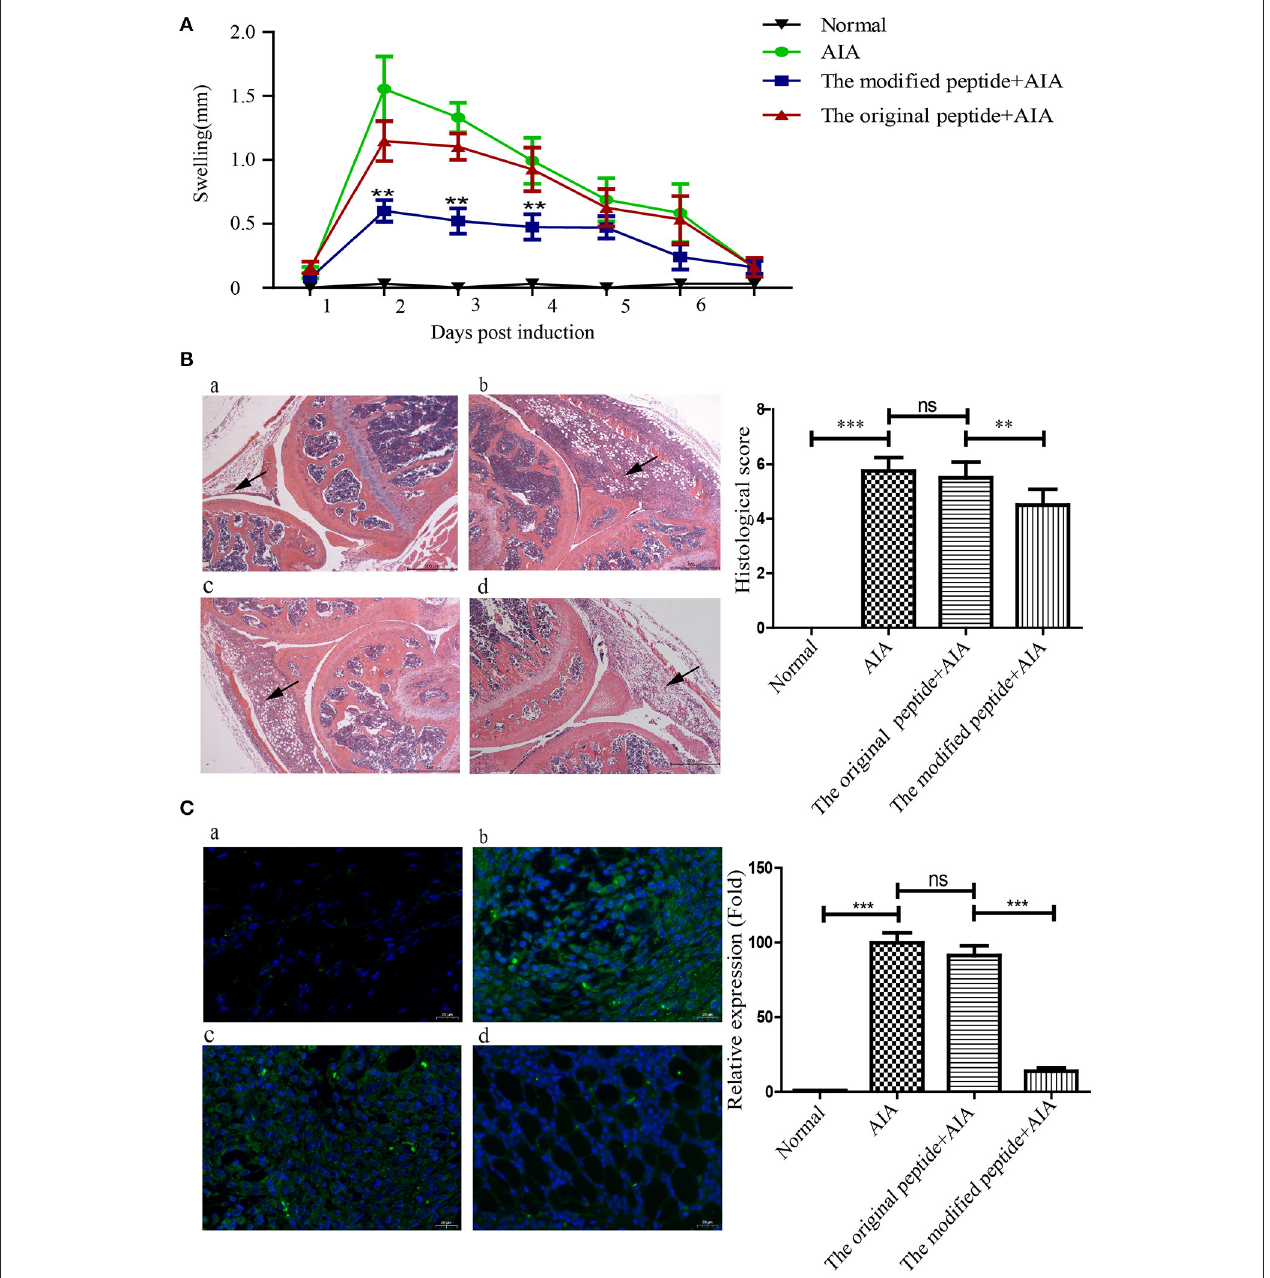
FIGURE 5 | Modified peptide reduced joint inflammation and membrane attack complex (MAC) deposition in mice with antigen-induced arthritis (AIA). The right knee joint of each mouse was intraarticularly injected with 10 µ l PBS as a control, while the left knee joint was injected with either 10 µ l PBS only (normal group), 25 µ g mBSA in 10 µ l PBS (AIA-only group), 40 µ g original peptide with 25 µ g mBSA in 10 µ l PBS (original peptide + AIA group), or 40 µ g modified peptide with 25 µ g mBSA in 10 µ l PBS (modified peptide + AIA group). (A) Swelling of the left knee joint relative to the right knee joint was measured daily. Data are presented as mean ± SD. n = 6, ** p < 0.01. (B) Representative histologic sections of murine knee joints stained with hematoxylin and eosin. a: normal group, b: AIA-only group, c: original peptide + AIA group, d: modified peptide + AIA group. n = 6. Magnification × 10. Arrowheads indicate the swollen synovial tissue. (C) Comparisons of C9 deposition in the knee joint sections among the four groups based on immunofluorescence assays. a: normal group, b: AIA-only group, c: original peptide + AIA group, d: modified peptide + AIA group. n = 6 *** p < 0.001, ns, not significant ( p > 0.05). peptide + AIA mice, but it was significantly weaker in the infiltration compared to the AIA-only or original peptide + AIA modified peptide + AIA mice, while the normal joints had no MAC deposition ( Figure 5C was clearly detected in the AIA-only mice and original